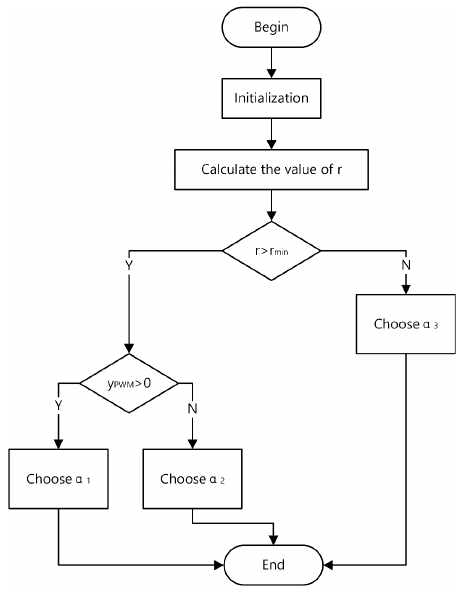
Figure 7. Order selection algorithm flow chart.